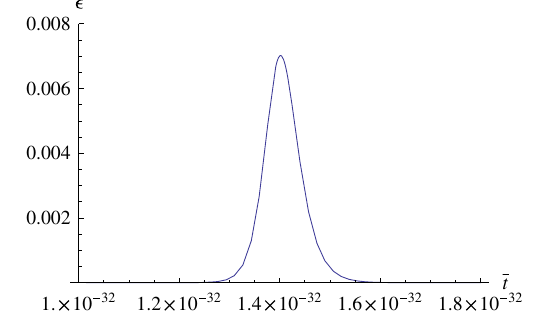
Fig. 1 The diagram presents the evolution of (cid:16) with respect to the cosmological time ¯ t . The time is expressed in seconds. The value of the parameter γ is assumed as 3 . 277 × 10 − 6 s 2 Mpc 2 . We also assume that km 2 Λ = 0 . 6911, where H = 67 . 74 km . Note that (cid:16) is not a constant 0 s Mpc 3 H 2 0 function when matter is not negligible (see Fig. 4)